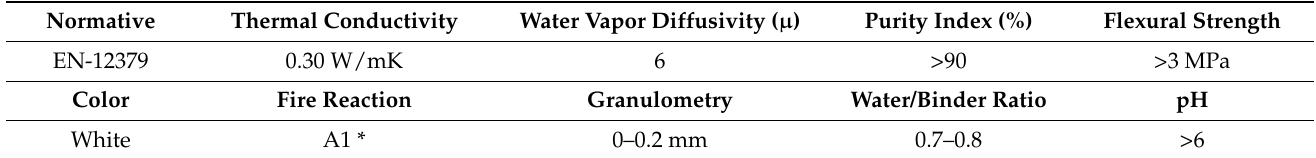
Table 2. Iberyola E-35 properties [15].